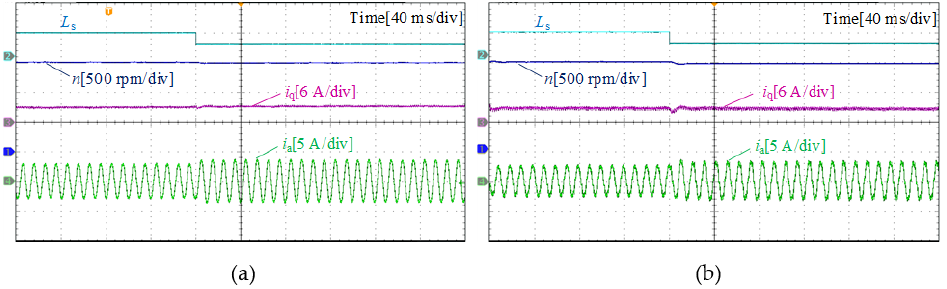
Figure 10. Experimental comparison with a −50% L s mismatch. ( a ) Proposed MPDSC. ( b ) Double- vector PDSC.